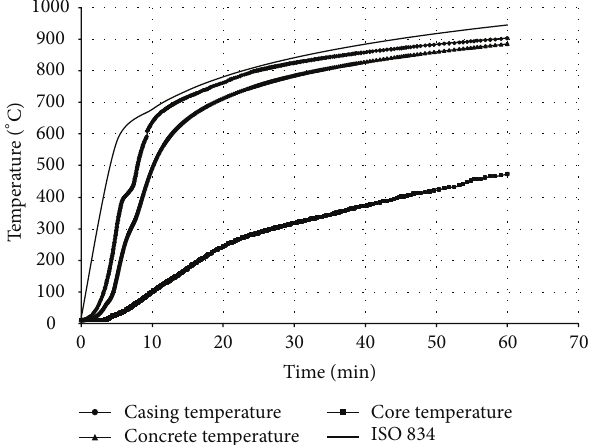
Figure 4: Nodal temperatures in BRB components.